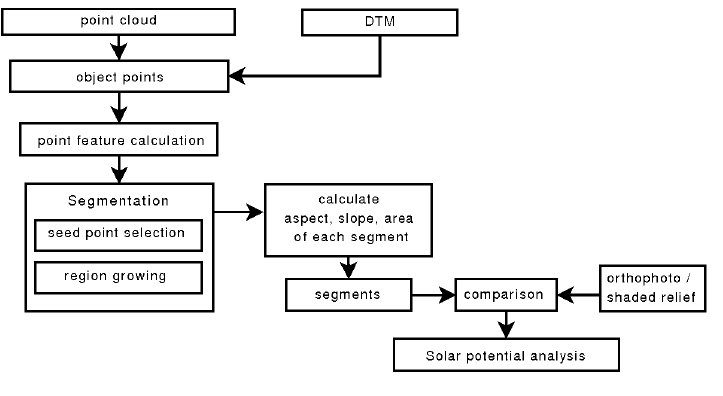
Figure 1. Workflow for roof plane detection in 3D point